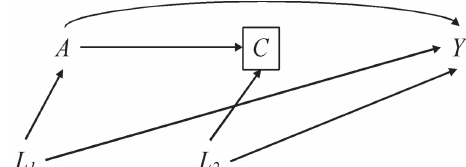
Figure 2. Causal Diagram Illustrating Confounding and Selection Bias. A is an exposure, Y is an outcome, C is a censoring status, L 1 is a vector of common causes of A and Y , and L 2 is a vector of common causes of C and Y . L 1 confounds the association between A and Y . When the uncensored sample ( C = 0) is analyzed, the analysis is e ff ectively conditioning on C = 0 (ie, a collider) and inducing selection bias through L 2